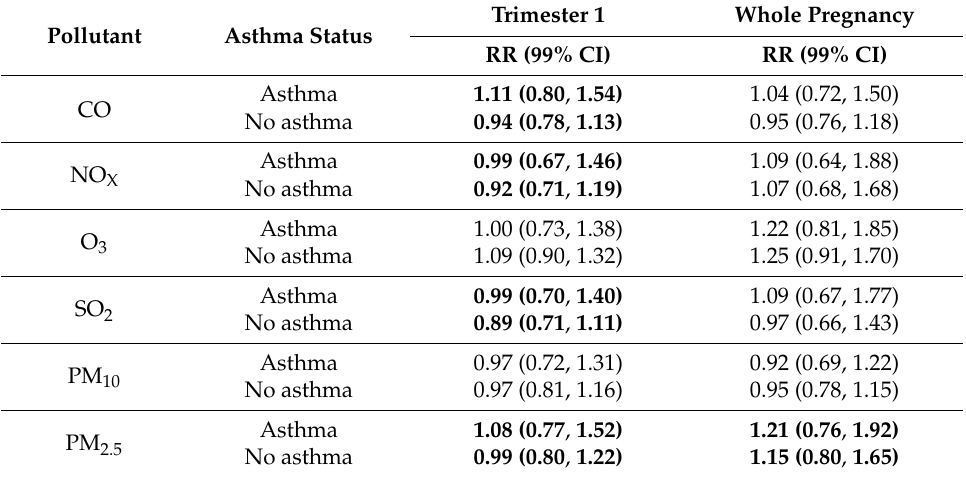
Table 4. Adjusted a relative risk (and 95% confidence intervals) for stillbirth per interquartile range (IQR) unit increase in pollutant by exposure window and asthma